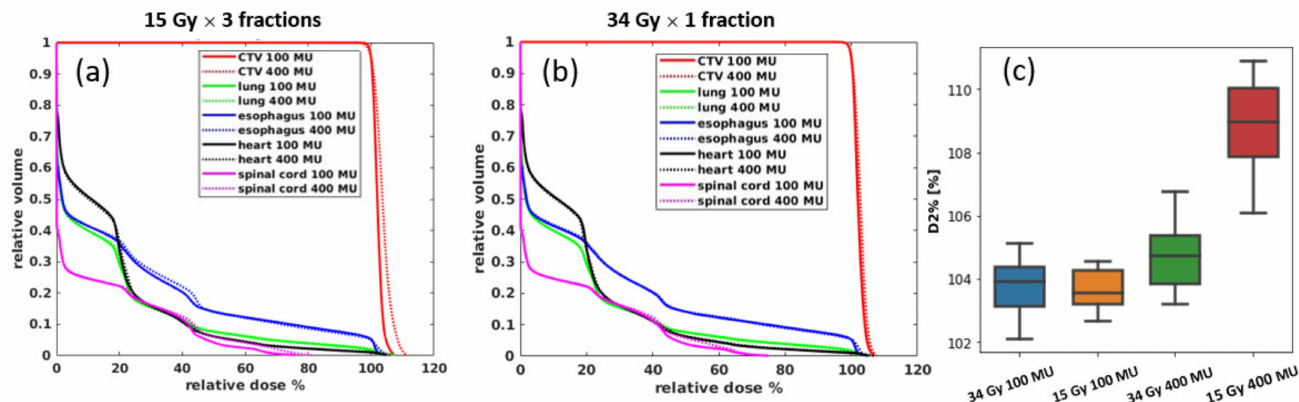
Figure 5. The average DVHs for all 9 patients for ( a ) 15 Gy × 3 plans and ( b ) 34 Gy × 1 plans; ( c ) is the target uniformity comparison using D 2 % as the representative for the hot dose; the ends of the box denote the interquartile (25–75th percentile), a horizontal line inside the box marks the median, and the whiskers are the two lines outside that represent the highest and lowest observation.